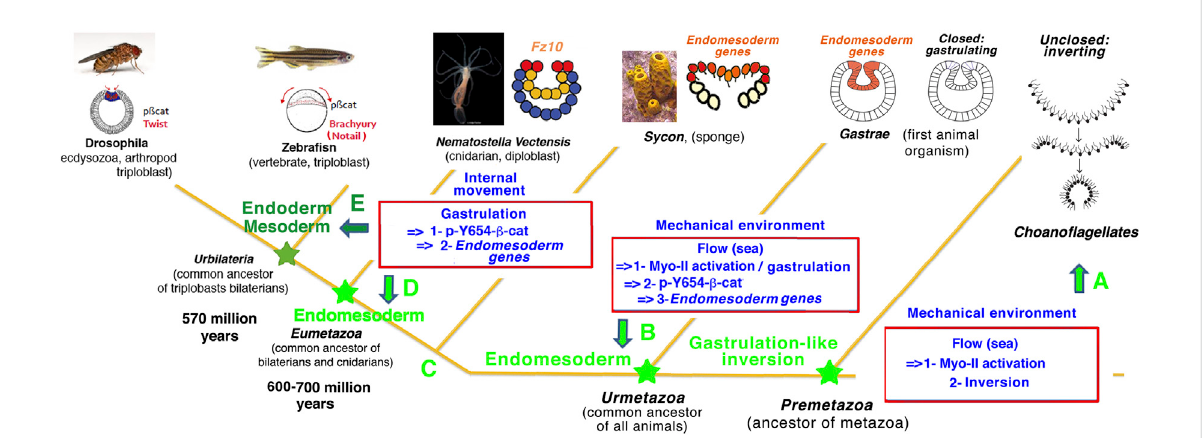
FIGURE 6 Mechanotransductive origins of fi rst Metazoa animal emergence evolutionary: a possible scenario. (A) Results: C. fl exa unclosed multicellular choano fl agellateinversion[schemefromBrunetetal.(2019)]aremechanotransductivelystimulatedbyhydrodynamic fl owmimickingsoftwaveson the sea shore in a Myo-II-dependent mechanotransductive process (Figure 5), like N. vectensis cnidaria gastrulation (Figure 1) and the mechanotransductive activation of Drosophila bilateria gastrulation (Mitrossilis et al., 2017). Evolutionary possible scenario: Myo-II mechanotransductive induction of constriction leading to multicellular inversion/gastrulation as possibly conserved along Metazoa evolution, from the hydrodynamically induced inversion of pre-Metazoa unclosed multicellular choano fl agellate. (B) Results: environmental hydrodynamic sea water hydrodynamic forces lead to mechanotransductive induction of gastrulation, with gastrulation strains mechanotransductively stimulating endomesoderm fz10 gene expression in the gastrulating tissue of the cnidaria N. vectensis in a Y654- β -cat phosphorylation activation mechanotransductive process conserved with bilateria (Brunetet al., 2013)(Figures 3, 4). Evolutionary possible scenario: pre-Metazoa inversionthat led to hydrodynamic induction of gastrulation after closing multicellular choano fl agellates, with gastrulation strains mechanotransductively leading toendomesodermgeneexpressioningastrulatingtissueafterevolutionaryemergenceof β -catmechanosensitivity,aspossibleconditionsoftheur- Metazoa emergence. (C,D) Results: internal morphogenetic movements of gastrulation lead to endomesodermal fz10 gene expression in the N. vectensis cnidaria embryo in a Y654- β -cat phosphorylation-dependent mechanotransductive process (Figures 3, 4). This is similar to the expression of Twist and brachyury endoderm and mesoderm genes in the early Drosophila and zebra fi sh bilateria embryos (Brunet et al., 2013). Evolutionary possible scenario: genetically regulated internal morphogenetic movements (gastrulation) possibly replaced external environmental (i.e., seawater) mechanical strains to stimulate gastrulation and endomesoderm speci fi cation in the Eumetazoan common ancestor of cnidaria and bilateria, thereby having initiated autonomous Metazoa embryogenesis. (E) The latter property has been possibly conserved in mesoderm and